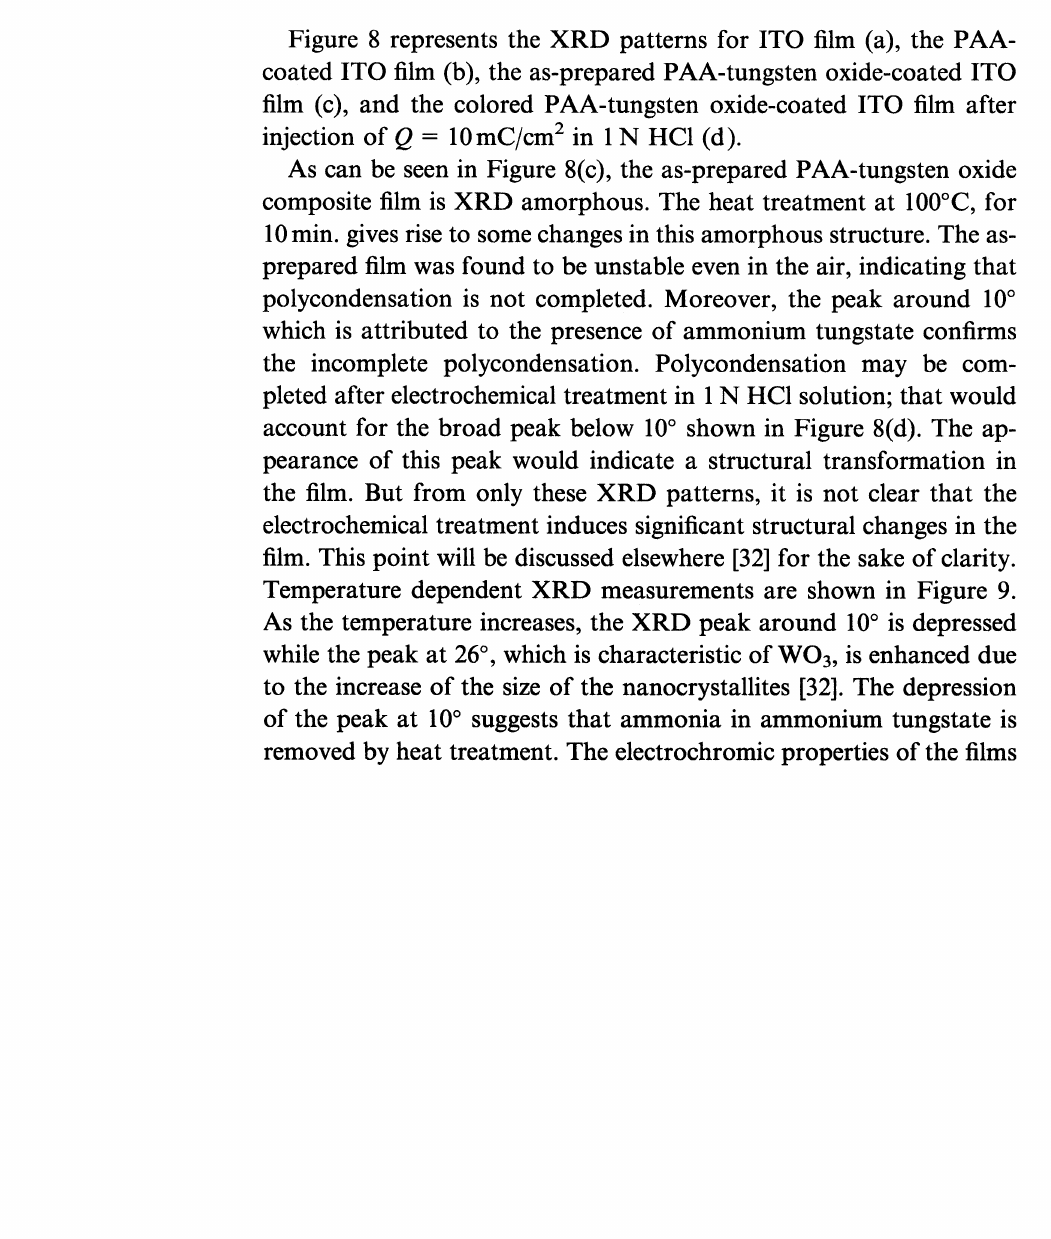
FIGURE 7 Electrochromic device attached with a